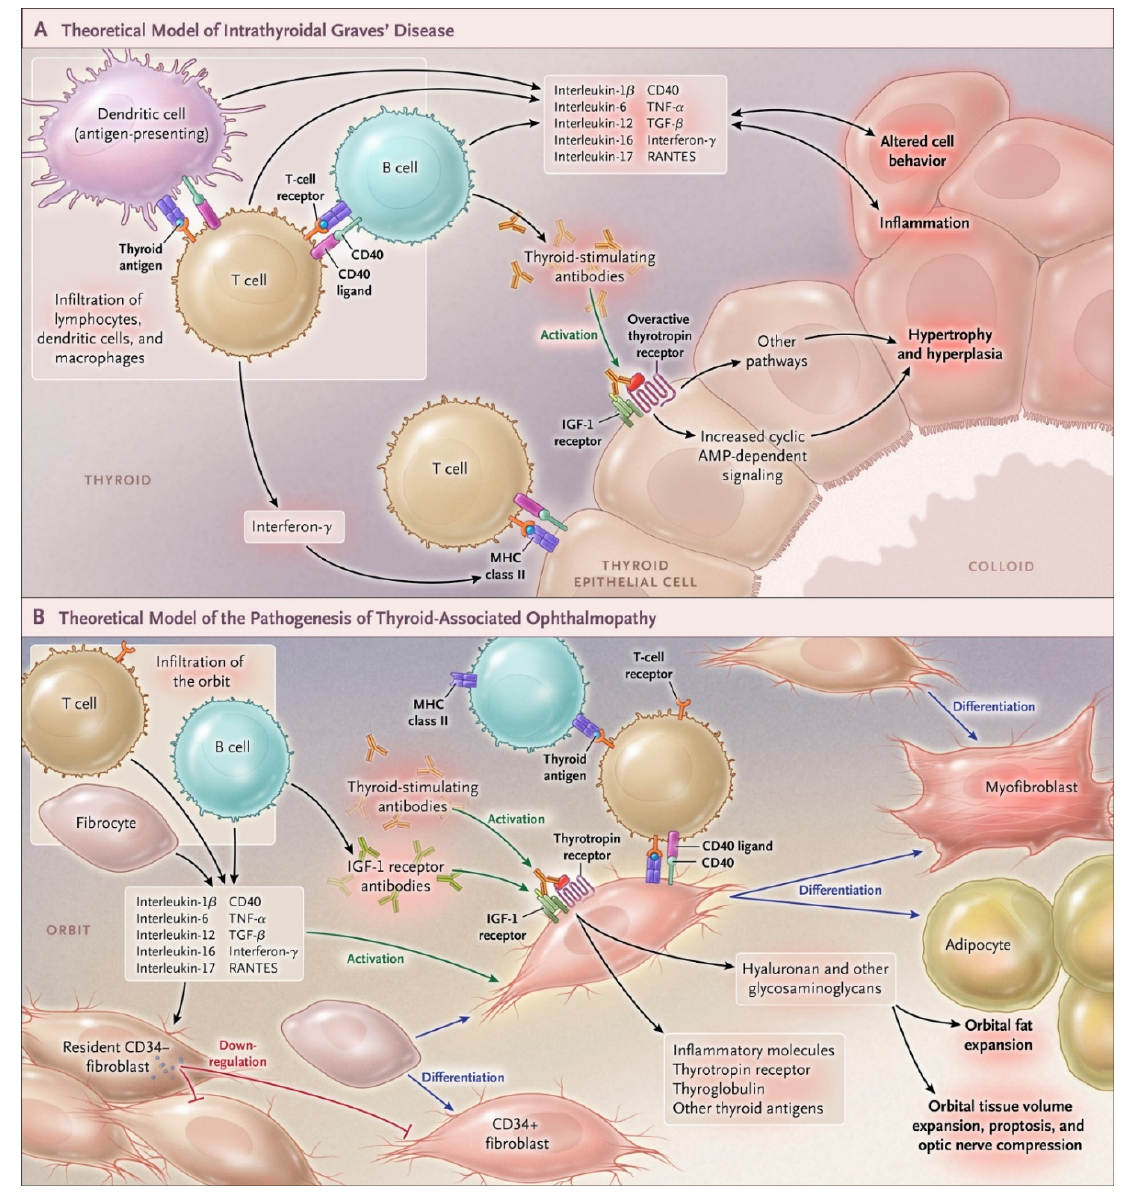
Figure 3. Involvement of IGF-I receptor in the pathogenesis of Graves’ disease and thyroid and thyroid-associated ophthalmopathy. ( A ) Theoretical model of how Graves’ disease occurs in the thyroid gland. Thyroid-stimulating immunoglobulins over-stimulate thyroid hormone production mediated through the thyrotropin receptor. Infiltrating B and T cells and antigen-presenting cells produce multiple cytokines. These include interleukins 1β, 6, and 12; interferon-γ; tumor necrosis factor α; and CD40 ligand. These result in inflammation. ( B ) Theoretical model of thyroid-associated ophthalmopathy. Orbit-infiltrating B and T cells and CD34 + fibrocytes interact, resulting in inflammation and tissue remodeling. Fibrocytes differentiate into orbital fibroblasts and further into myofibroblasts or adipocytes. Both residential and infiltrating cells can produce cytokines, including interleukins 1β, 6, 8, and 16; tumor necrosis factor α (TNF-α); RANTES (regulated on activation, normal T-cell expressed and secreted); and CD40 ligand. Fibrocyte-derivative CD34 + fibroblasts express low-level thyrotropin receptor, thyroglobulin, and thyroperoxidase. Pathogenic IgGs activate the thyrotropin– insulin-like growth factor 1 (IGF-1) receptor complex, resulting in production of inflammatory molecules and glycosaminoglycans. From N. Engl. J. Med, Smith T.J. and Hegedus L., Graves’ Disease, 375; 1552–1565. Reprinted with permission from ref. [89]. Copyright 2016 Massachusetts Medical Society.